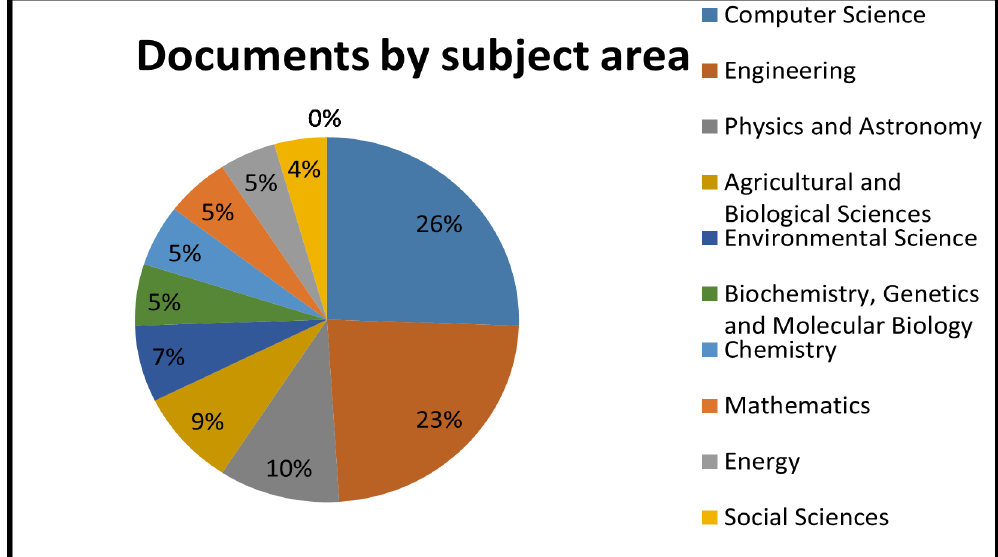
Figure 8. Subject area-wise analysis for IoT in agriculture-retrieved